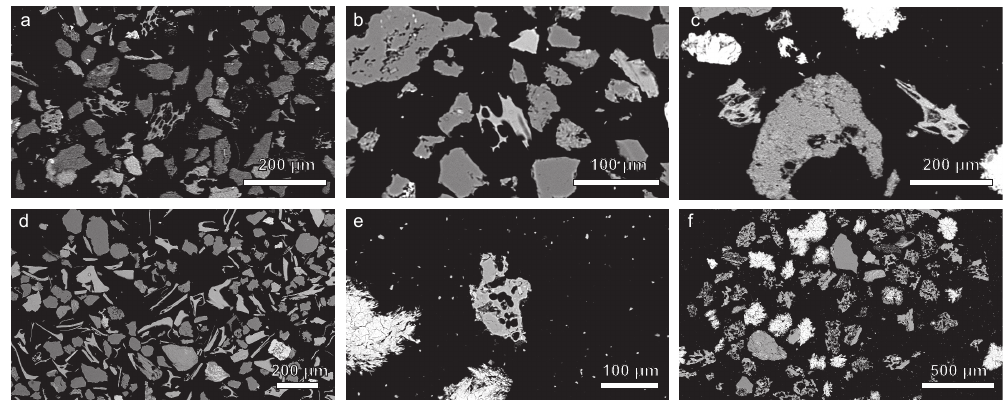
Fig. 5. Selected scanning electron microscope (SEM) photographs of the investigated tephras and cryptotephras: (a) vesicular micro-pumice fragments and glass shards of PT0915-3, (b) vesicular micro-pumice of PT0915-4, (c) highly vesicular glass shards of PT0915-8, (d) thick-